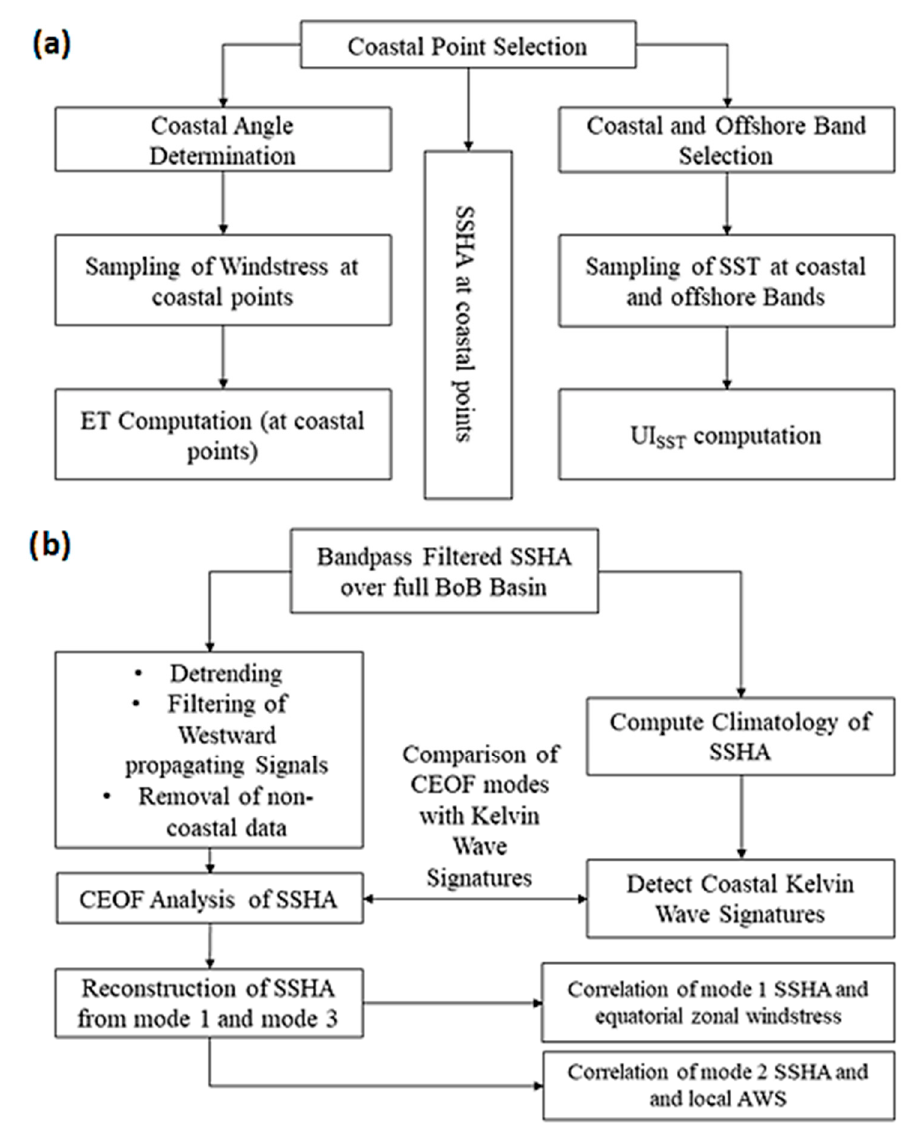
Figure 2. ( a ) Methodology of computation of upwelling indicators at the coastal points; ( b ) Analysis of spatial SSHA for detection of coastal Kelvin waves.